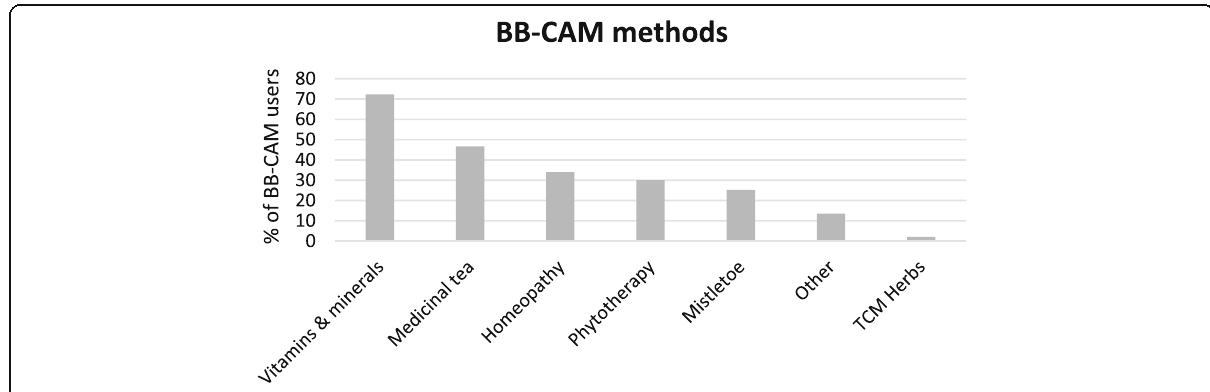
Fig. 1 Used BB-CAM methods sorted by highest intake. Values are calculated as percentages of BB-CAM users ( n =